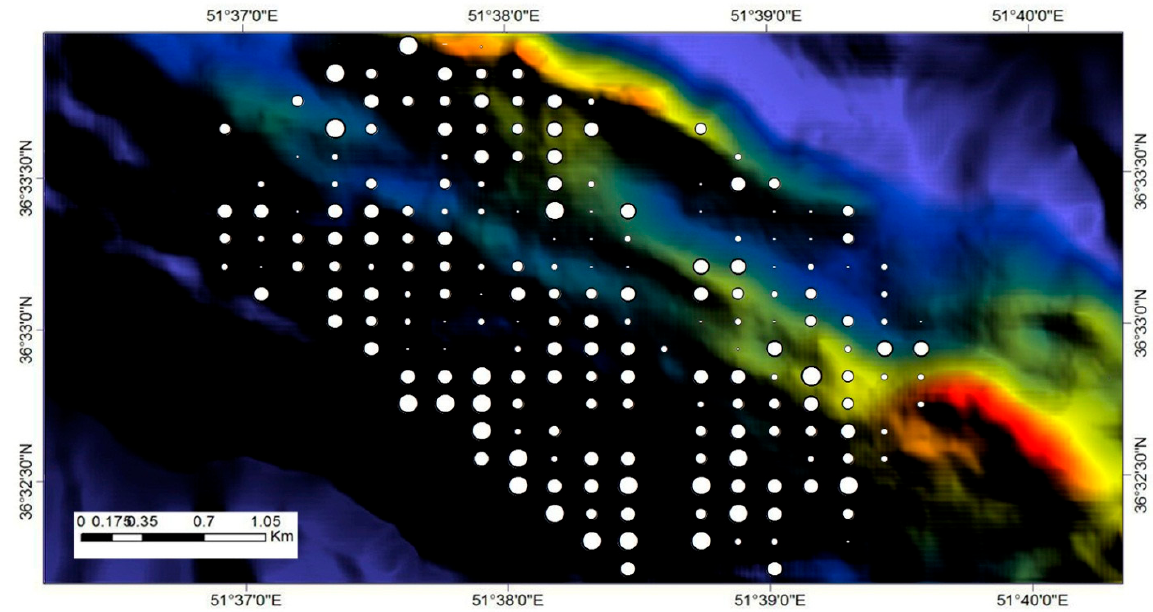
Figure 9. Spatial variation of tree species diversity at the plot level, which is estimated according to the Shannon Wiener index. The large circles coincide with high index values (high species diversity with an upper value of 1.6), whereas small circles coincide to low values (low species diversity with a lower value of 0.1).